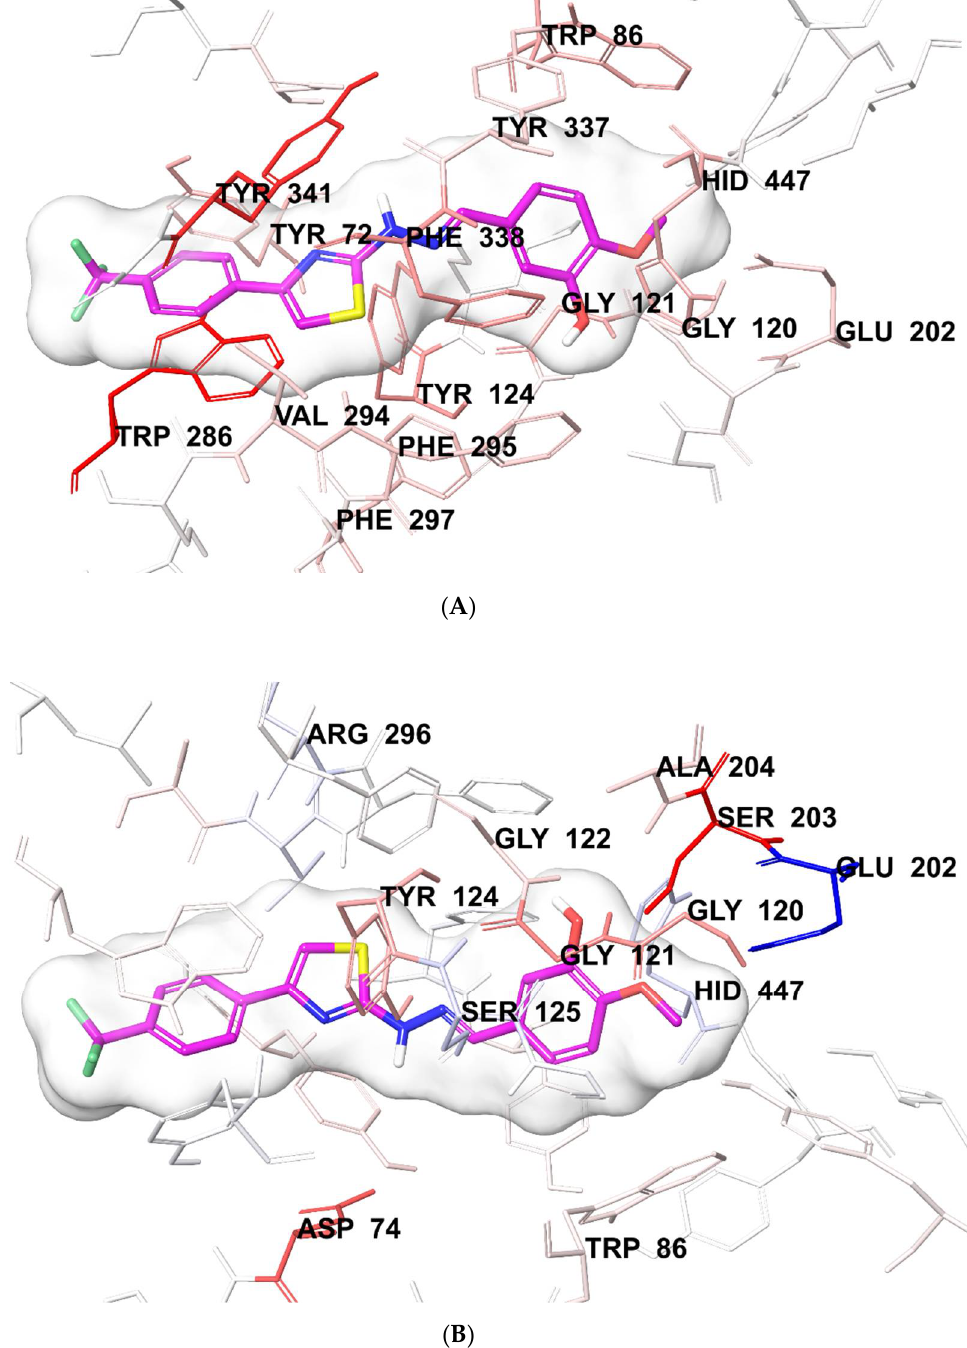
Figure 5. The van der Waals ( A ) and electrostatic interactions ( B ) of compound 2i with an active region of AChE. The active ligand has a lot of favorable van der Waals and electrostatic interactions. The residues are colored (blue, red, and pink) according to the distance from ligand by per-residue interaction